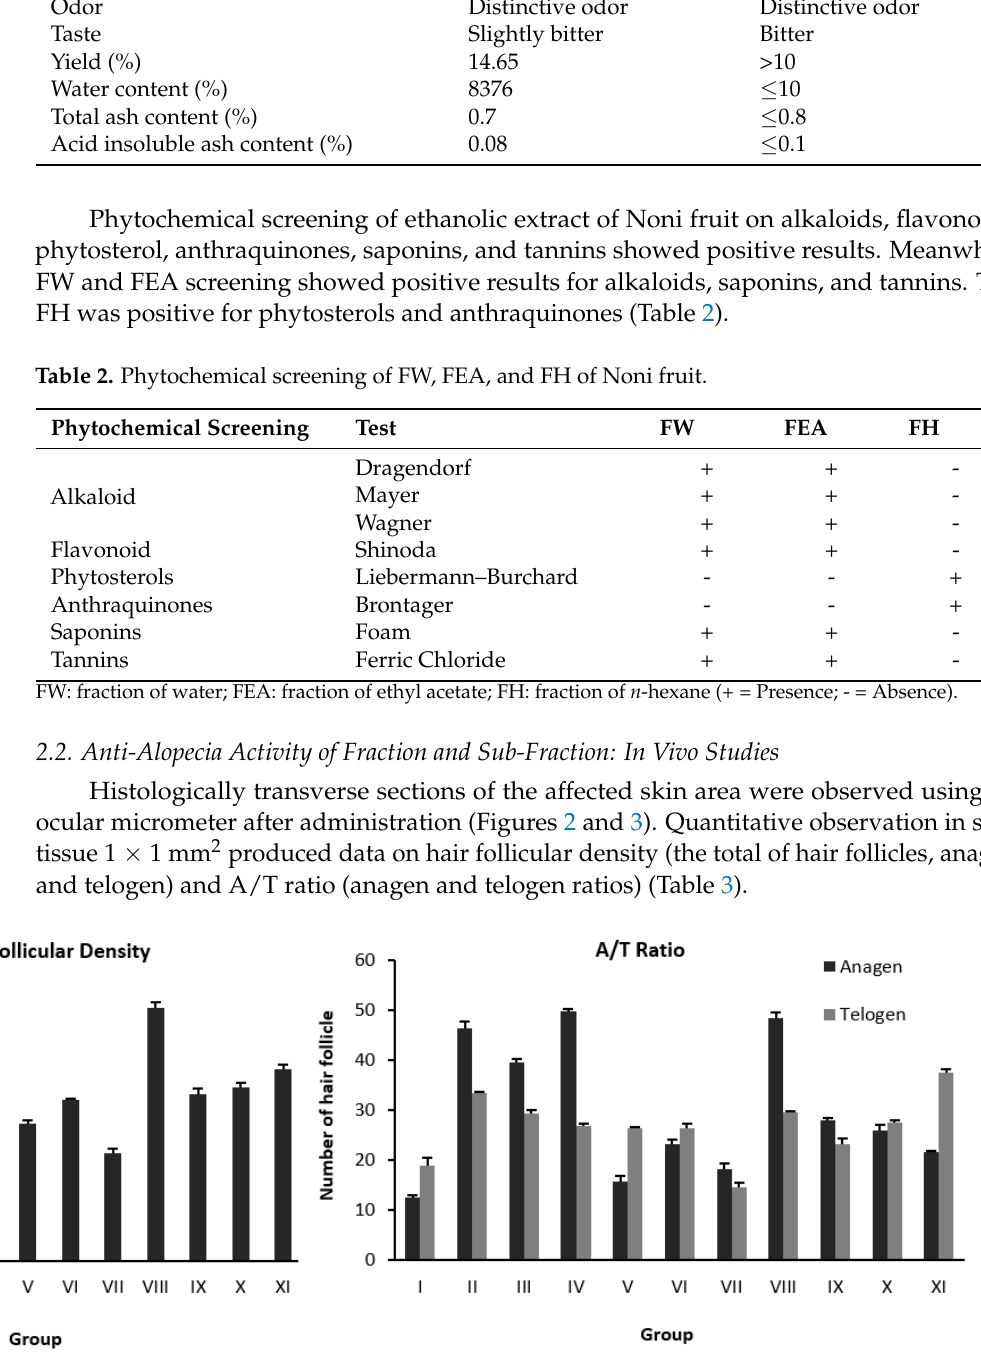
Figure 2. Graph of the calculation of hair follicular density and A/T ratio.